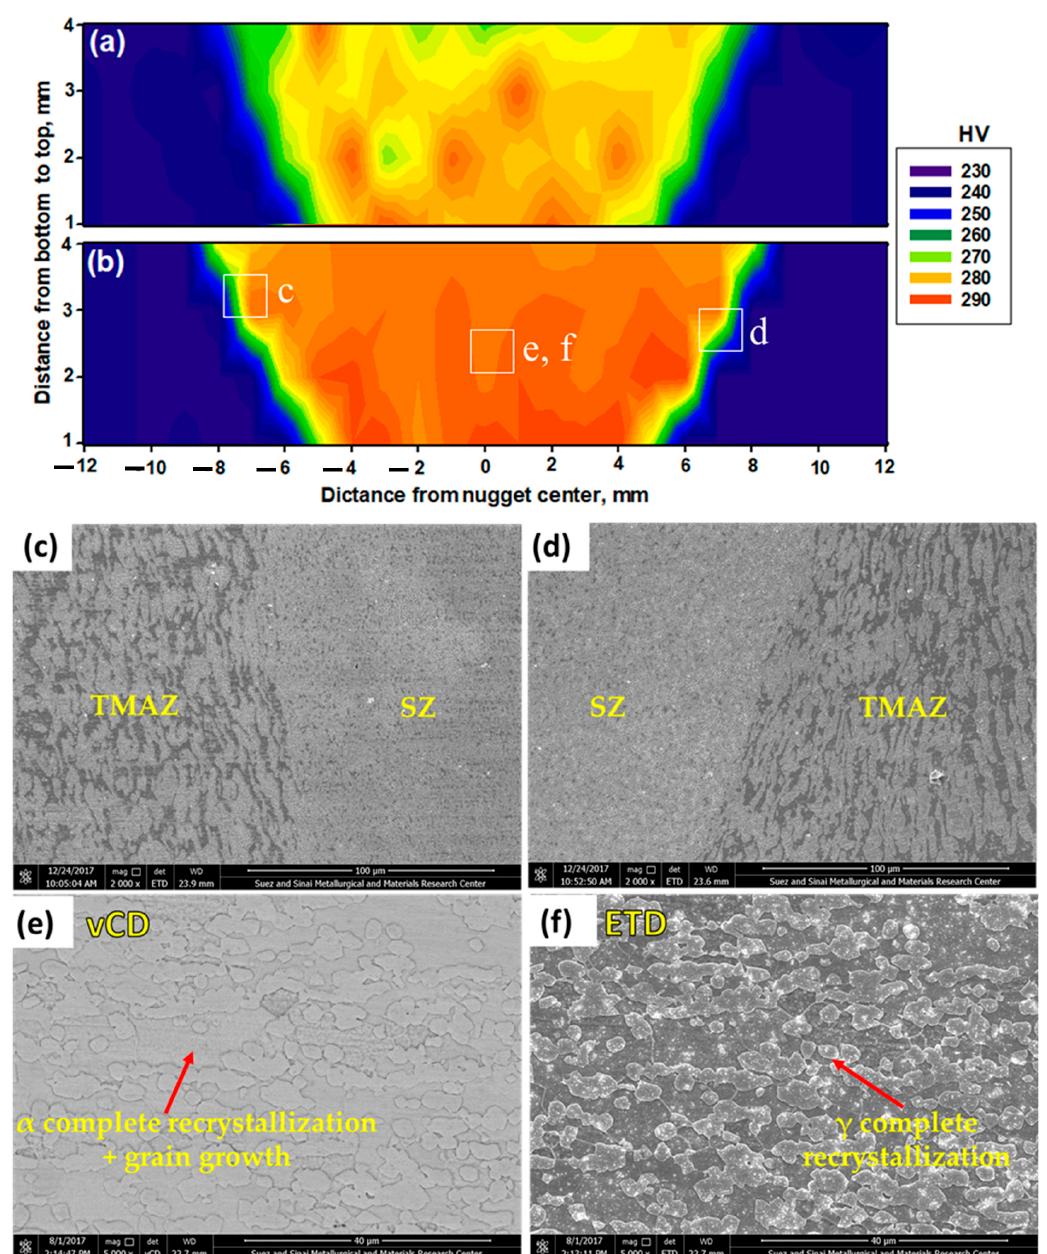
Figure 10. Hardness maps across through the transverse cross-section of the joints welded at ( a ) 600 rpm, 50 mm/min, and 14 kN, and ( b ) 300 rpm, 25 mm/min, and 20 kN. SEM images at the SZ–TMAZ interface ( c ) AS side and ( d ) RS side. SEM images of SZ for butt joint welded at 300 rpm, 25 mm/min, and 20 kN in ( e ) vCD and ( f ) ETD modes. The tensile properties of the welded joints depend on the joint efficiency and are governed by the welding parameters in terms of rotational speed, travel speed, and applied downward force. In addition, the failure during tensile tests occurred at the weakest part